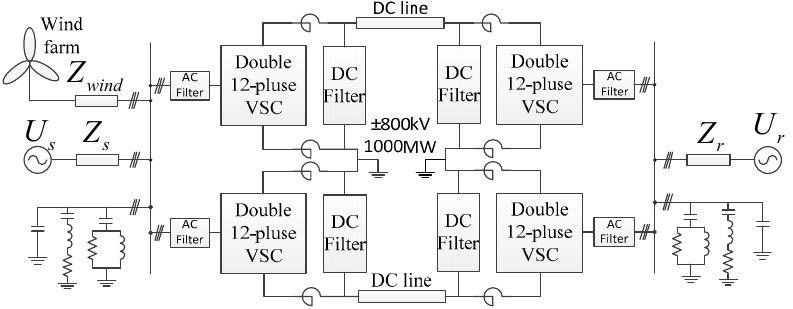
Figure 13. Simulation topology diagram of the ±800 kV system.